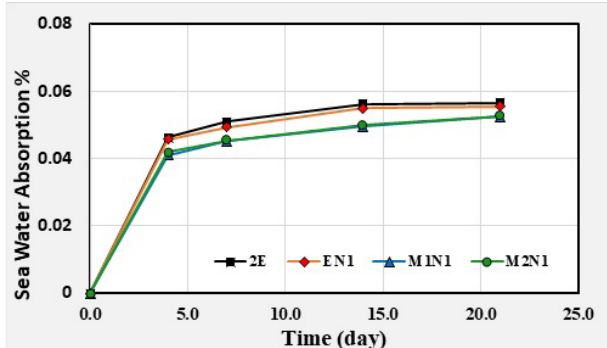
O particles when immersed in 3.5wt%NaCl. 2 3